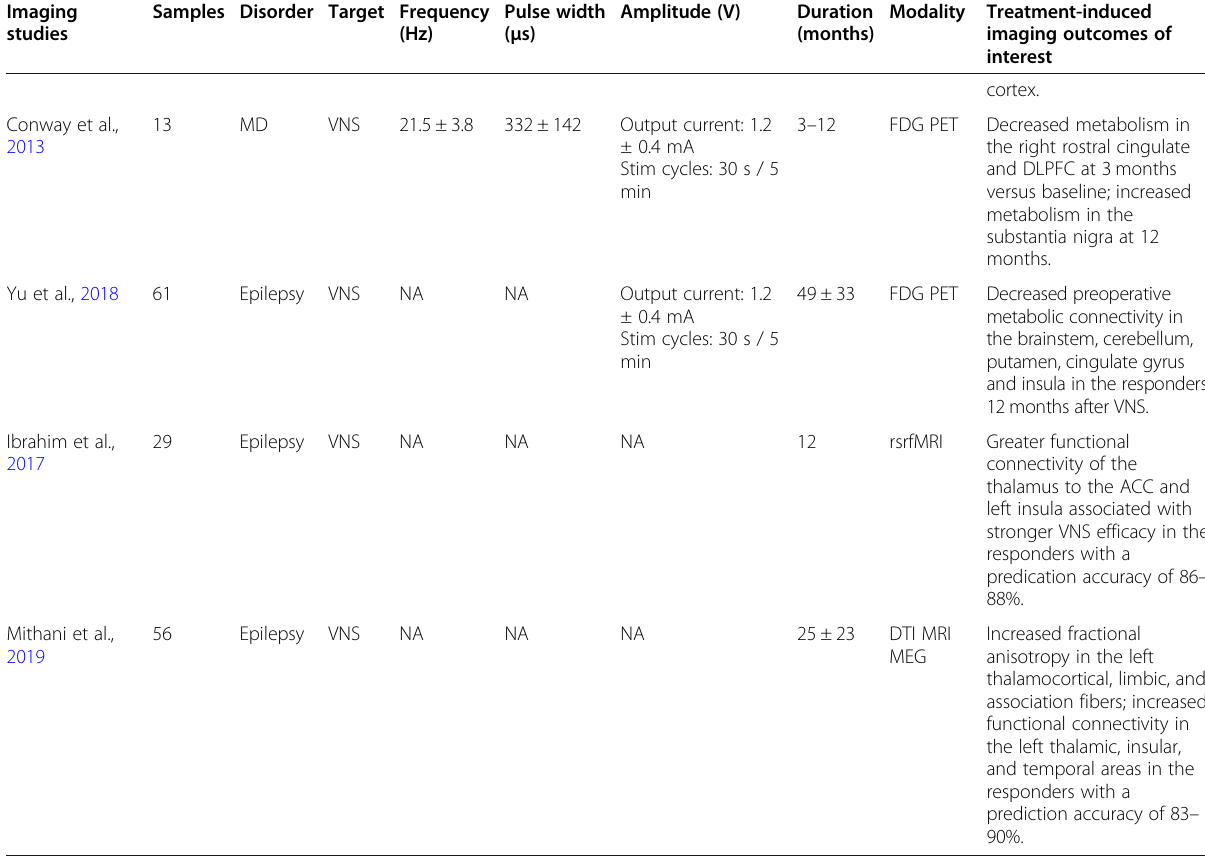
Table 1 Clinical characteristics and primary imaging outcomes of deep brain stimulation therapies in select neurodegenerative